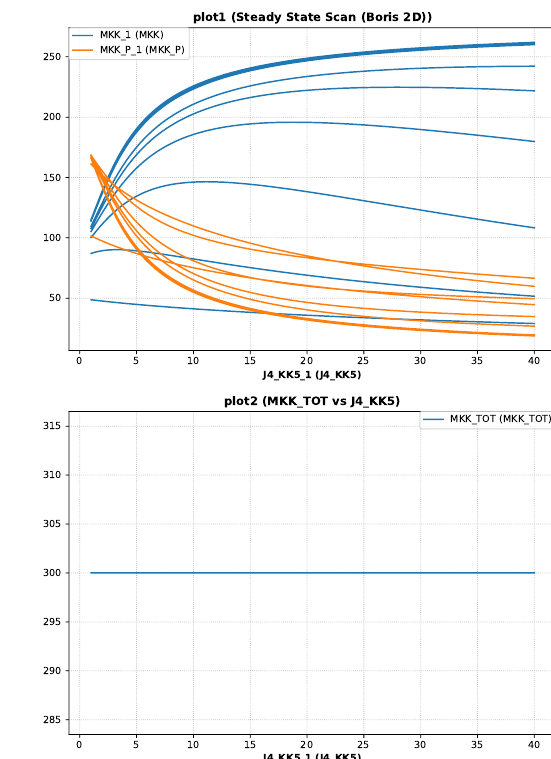
Figure A.11: The simulation result gained from the simulation description given in Listing A.7. Simulation with SED-ML web tools [2].